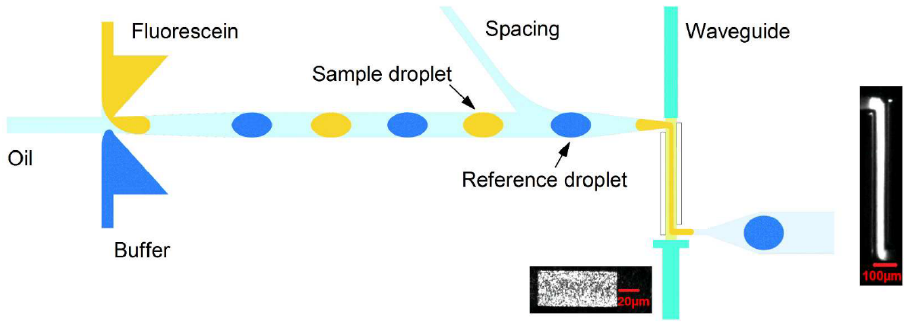
Figure 20. Use of liquid-core optical waveguiding through low-cost polymer microfluidics in PDMS, facilitating droplet analysis in the KHz range. Reprinted with permission from [126]. Copyright (2017) American Chemical Society.